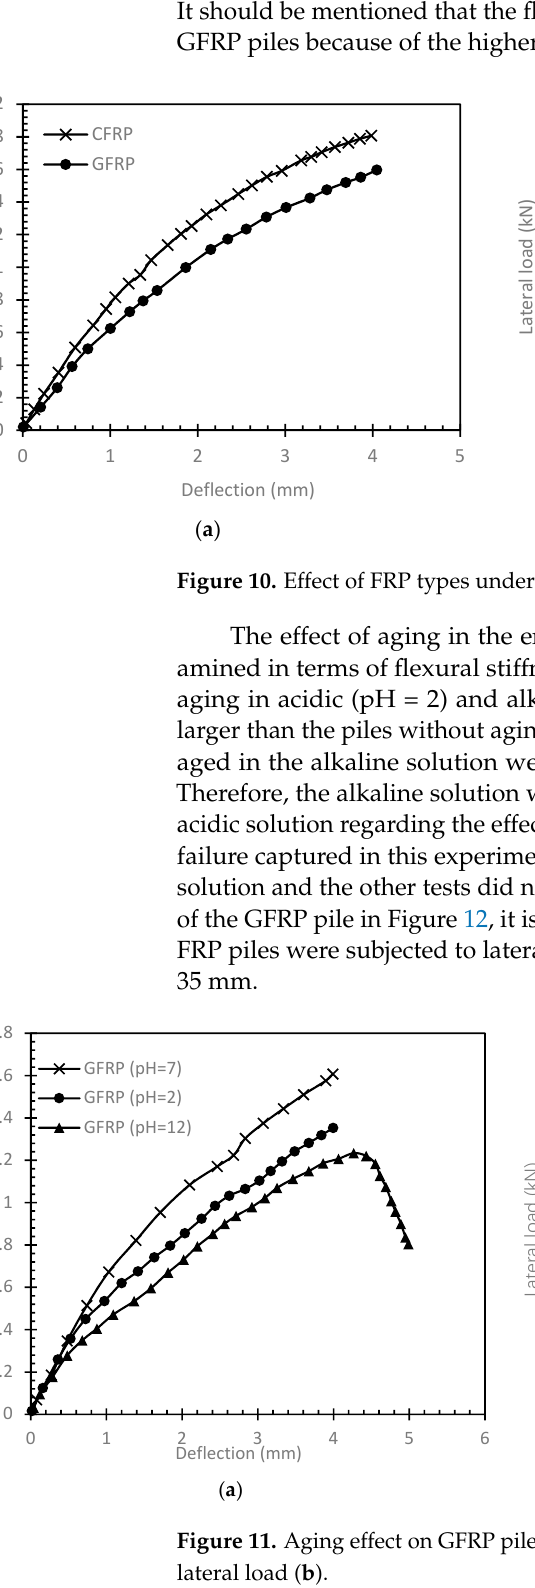
Figure 12. Crack on the tension side of the GFRP pile after aging in pH = 12. 5. Discussion Figure 13 summarises the factors that influence the behaviour of FRP piles under an axial load. The factors influencing the behaviour of the FRP piles can be categorised into two groups: the shearing resistance of the soils or the FRP type. The shearing resistance can be affected by the relative density or confined pressure of the soil condition. When the soil matrix becomes denser (i.e., higher relative density), the interlocking between the par ‐ ticles of soils becomes stronger, resulting in a larger shearing resistance in the soil. Simi ‐ larly, when soils are confined in a larger pressure, the shear strength will increase based on the Mohr − Coulomb failure criterion (Equation (1)). A larger shear strength of soils will bring a larger shearing resistance against soil particles being pushed away, when a pile is pushed downwards.